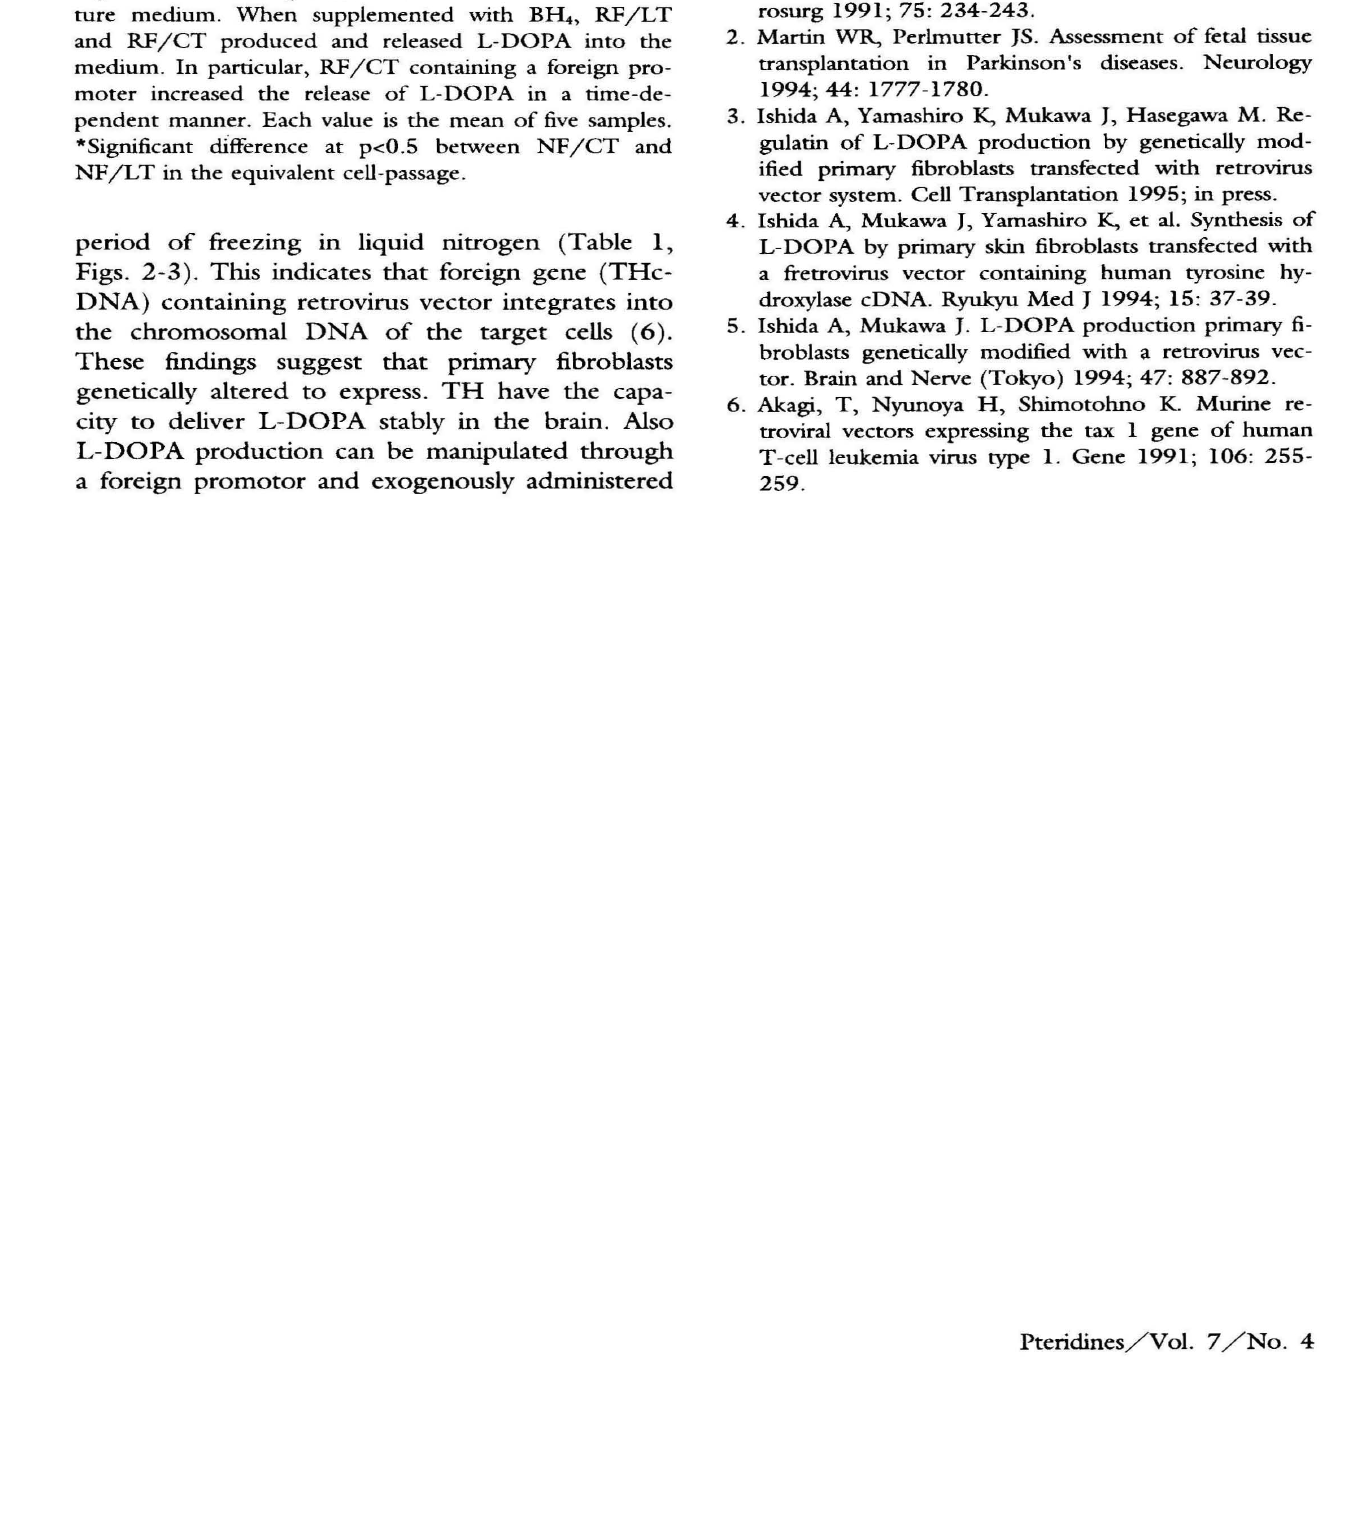
Figs. 2-3). This indicates that foreign gene (THc DNA) containing retrovirus vector integrates into the chromosomal DNA of the target cells